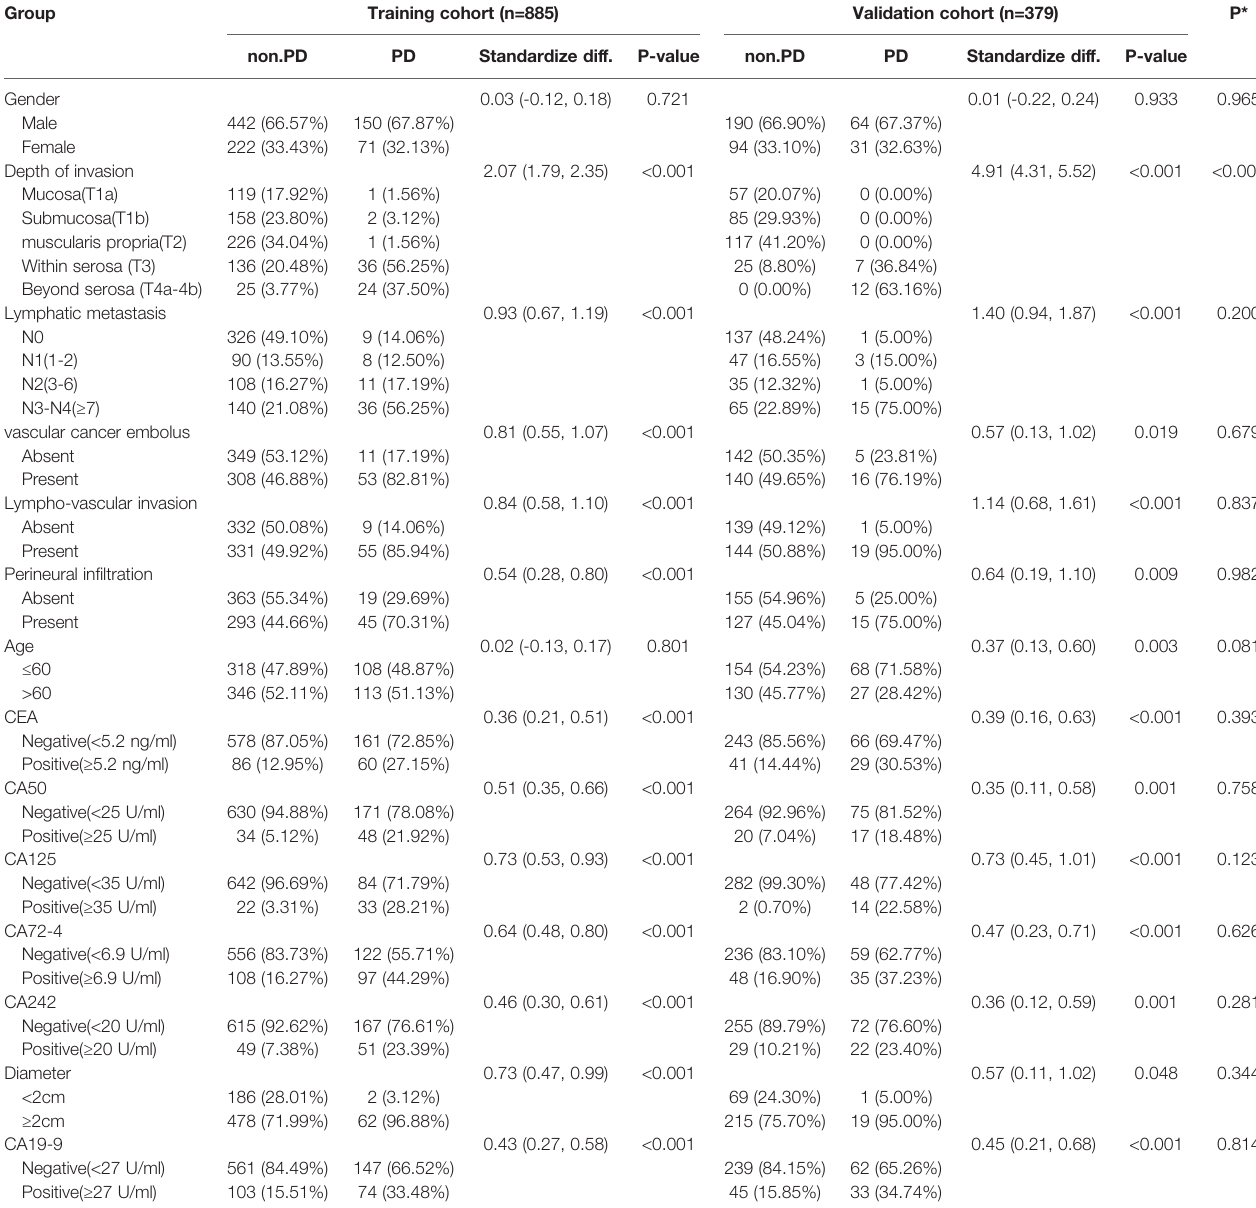
TABLE 1 | Correlation between peritoneal dissemination and clinicopathologic features [n (%)]. Group Training cohort (n=885) Validation cohort (n=379) P* non.PD PD Standardize diff. P-value non.PD PD Standardize diff.